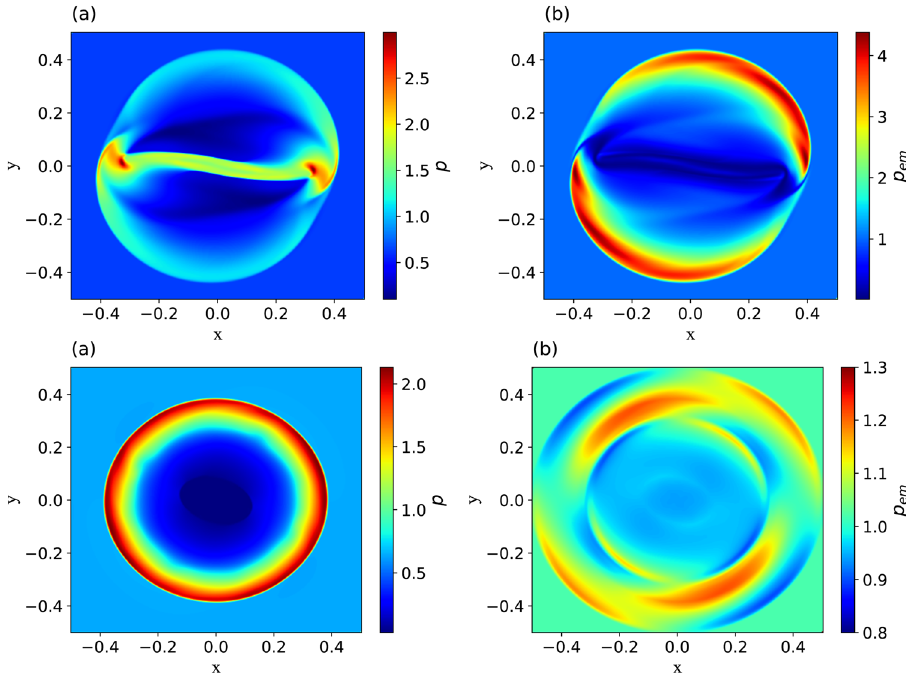
Fig. 13 a The pressure of fluid and b the energy density of the electromagnetic fields at t = 1 . 4 are shown in the 2D resistive rotor test in the Milne coordinates in the case of σ =